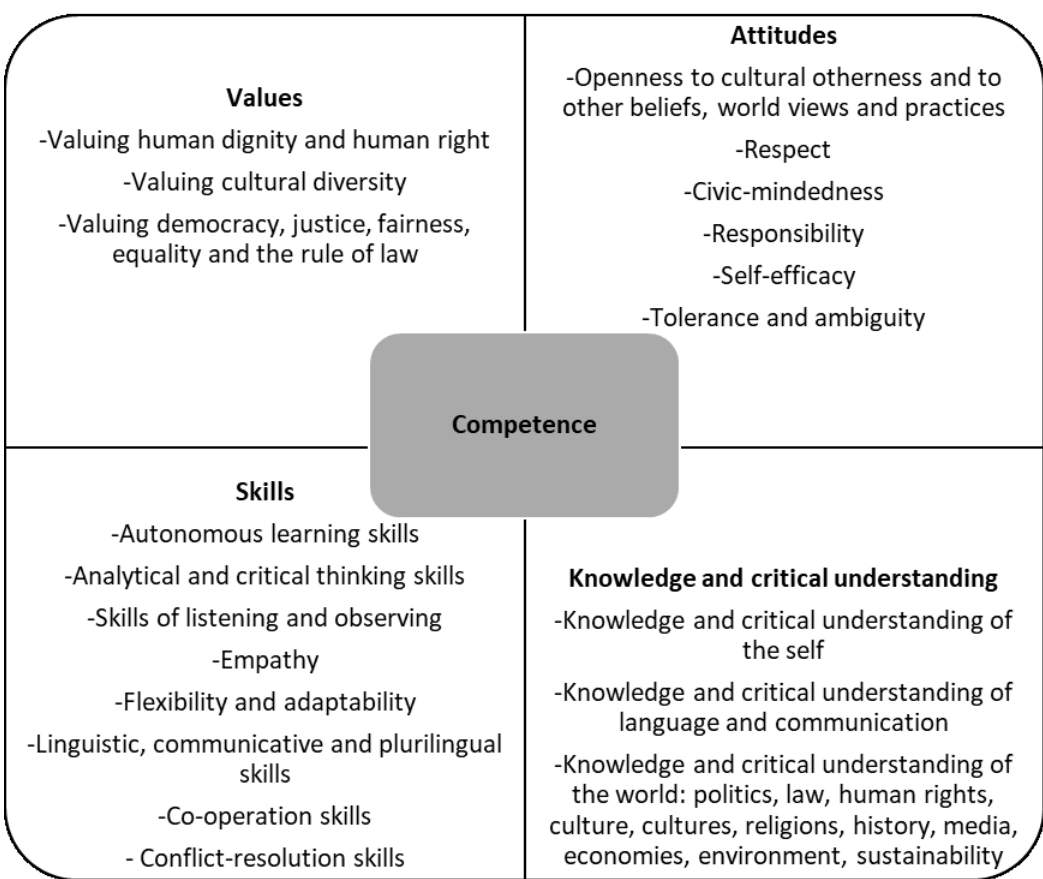
Figure 1: The 20 competences of the